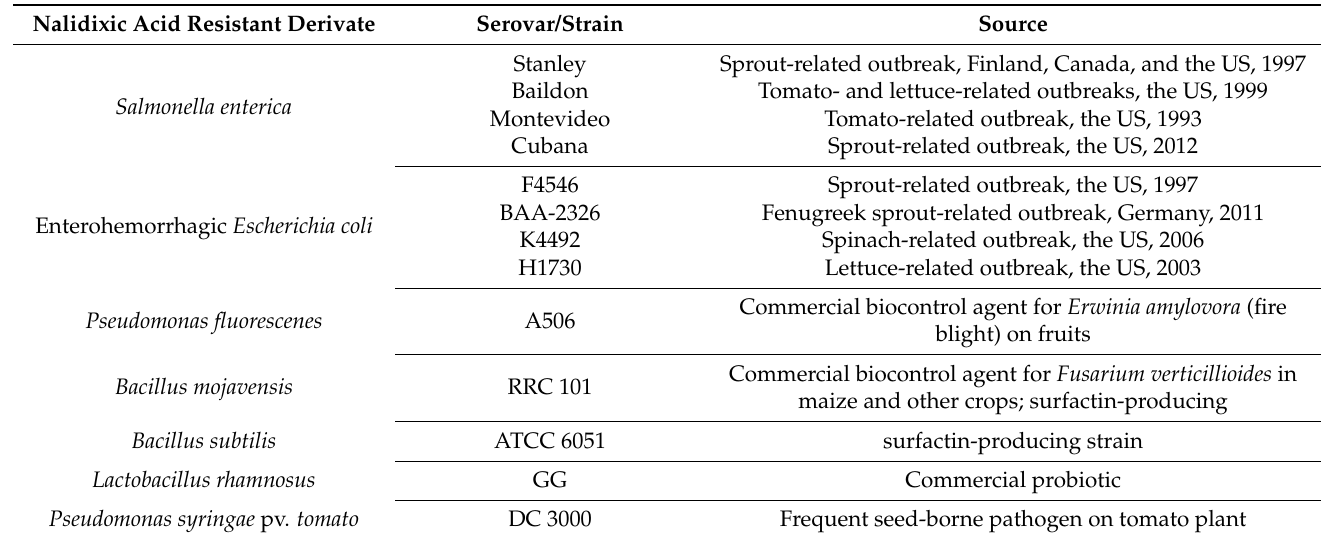
Table 1. Bacterial strains used in this